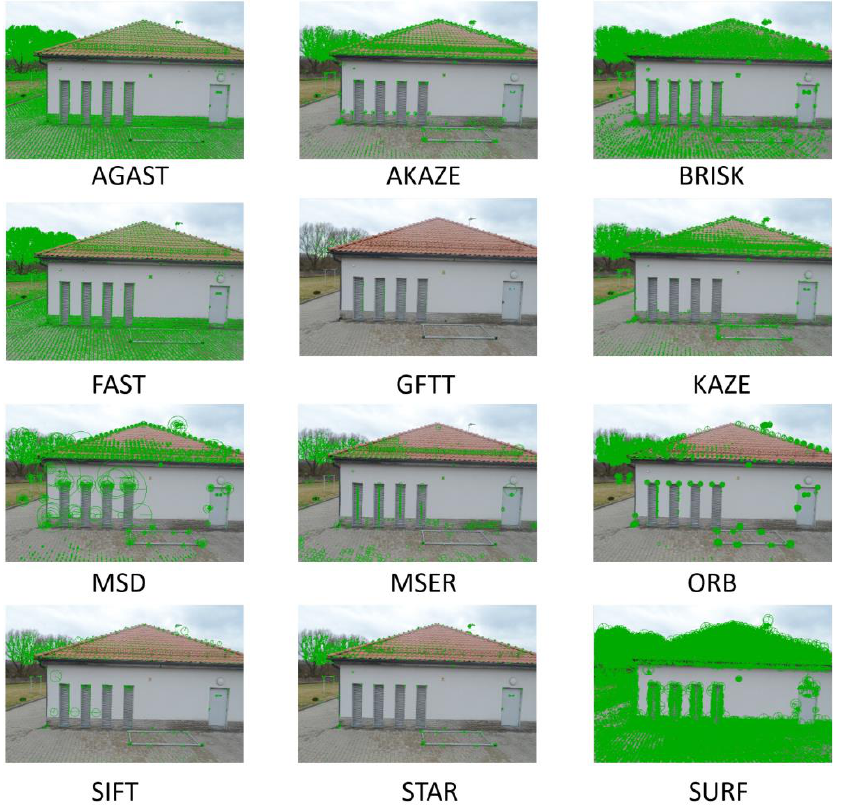
Figure A8. Differences between keypoints detection using tested detectors for one image of CRBeDaSet. The presentations of keypoint detection for four elevations (4 × 2 images) are included in supplementary files. Table A1. The results of matching performed for elevation 1. The description is performed accord- ing to Equation (10), and the “ * ” symbol means descriptor not available. Detectors E1 Descriptors